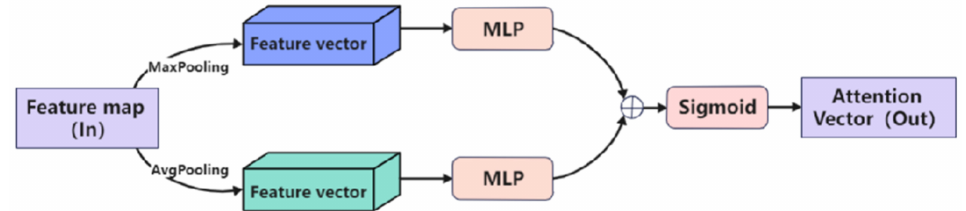
Figure 3. Schematic diagram of the channel attention module. As mentioned in the paper, the channel attention module uses max pooling and average pooling to extract information and uses MLP and other methods to calculate the channel attention weight vector.